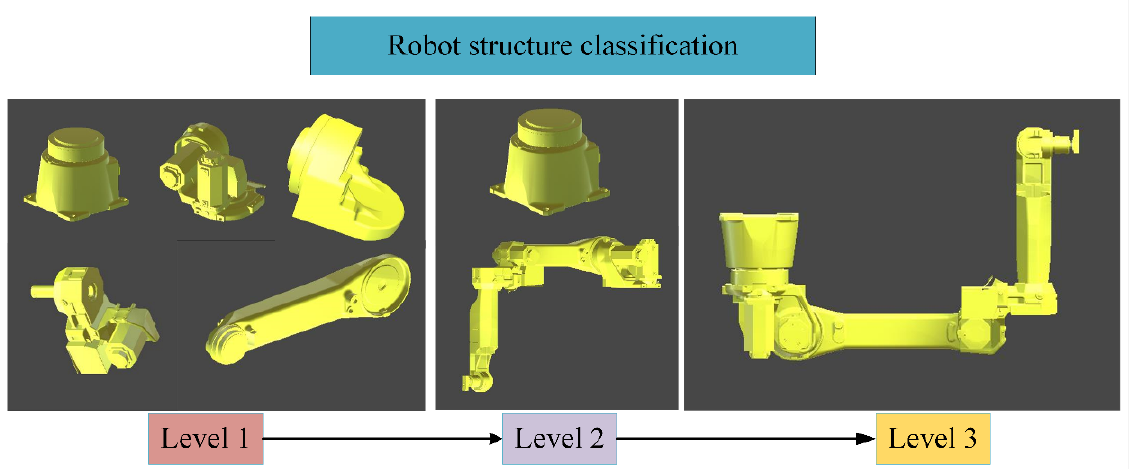
Figure 5. Six-axis robot structure classification.